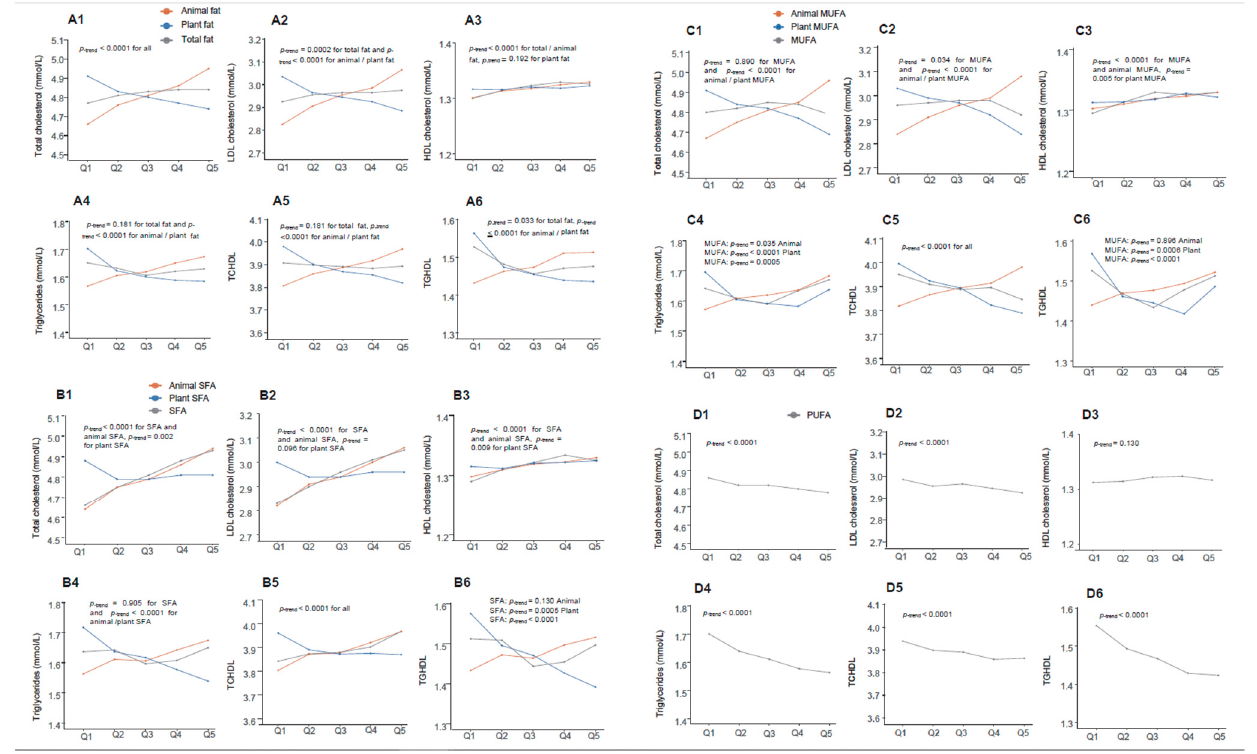
Figure 2. Changing trends of lipid biomarkers across quintiles of various dietary fats. Model adjusted for total energy, dietary fiber, dietary cholesterol, vegetables, fruits, age, sex, north/south region, urban/rural location, education (categorical), smoking (categorical by status and cigarettes), drinking status (categorical by grams), BMI (continuous), physical activity (continuous), sleep time (continuous), diagnosed hypertension (yes/no), and family history (yes/no). ( A1 – A6 ): Total/animal/plant fat; ( B1 – B6 ): SFA and animal/plant SFA; ( C1 – C6 ): MUFA and animal/plant MUFA; ( D1 – D6 ): PUFA.